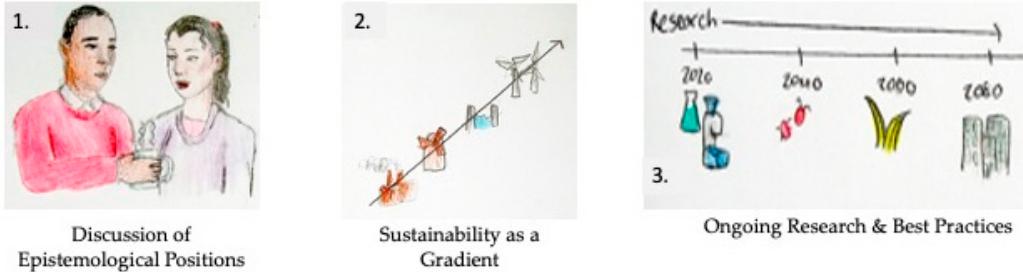
Figure 4. Three recommendations to improve the clarity of the dialogue amongst teams: (1) articulation of epistemological perspectives amongst team members; (2) application of a gradient orientation and (3) dialogue and further research.